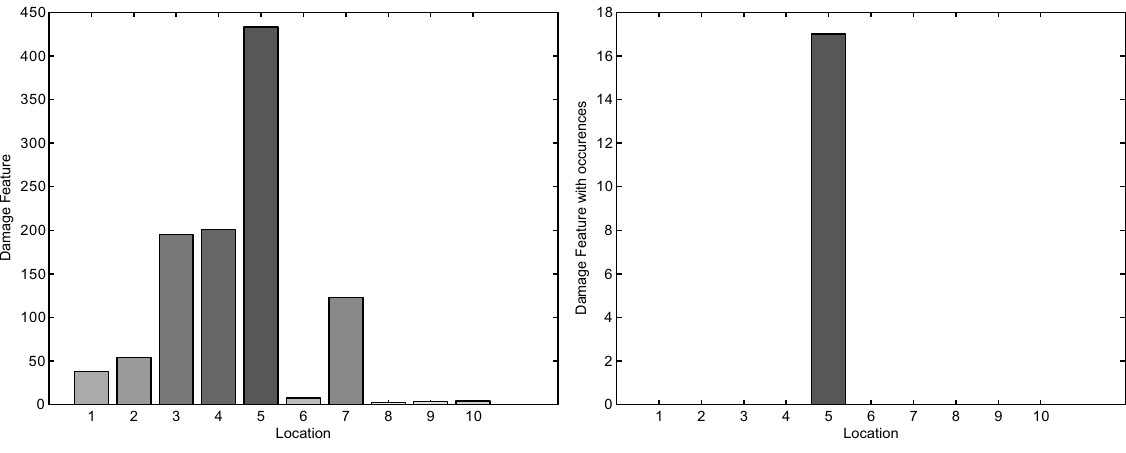
Fig. 21. Damage feature without and with occurrences for damaged structure and changing loading conditions, frequency range 50.5–51.5